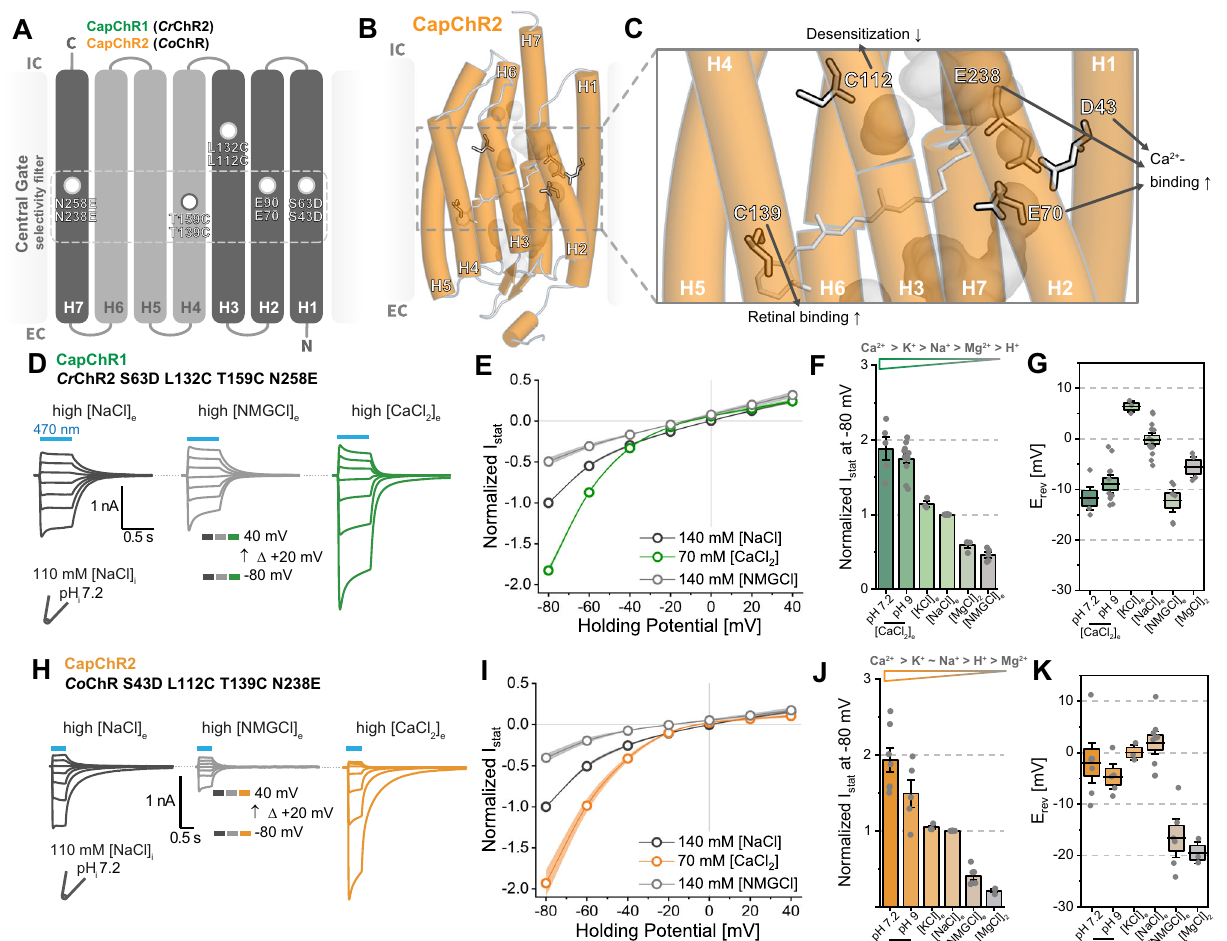
Fig. 2 | Engineering of Calcium-permeable ChannelRhodopsins (CapChRs). A Design strategy for CapChR1 (green) and CapChR2 (orange). Pore helices coloured in dark grey and miscellaneous helices in light grey. B and C Exemplary CapChR2 homology model depicting mutated residues and their intended effects (based on structure data, PDB ID: 6EID, https://doi.org/10.2210/pdb6EID/pdb). Grey mesh represents water accessibility according to MD simulations. D and H Representative photocurrent traces of CapChR1 (green) and CapChR2 (orange) respectively, recorded from − 80 to +40mV in 20mV steps in ND7/23 cells (blue bar: illumination with saturating, 470nm light; ~1.9mW/mm²). E and I Current – voltage relationships for CapChR1 and CapChR2 under varying extra- cellular conditions (shadows represent the SEM; normalized to high [NaCl] e at − 80mV). F and J Stationary photocurrents for CapChR1 and CapChR2 at the